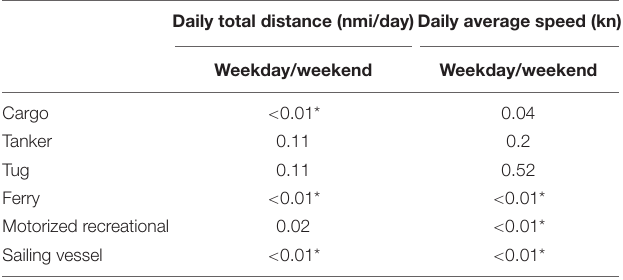
TABLE 4 | Mood’s median test results ( p -values) comparing daily total distance (nmi/day) and daily average speed (kn) across